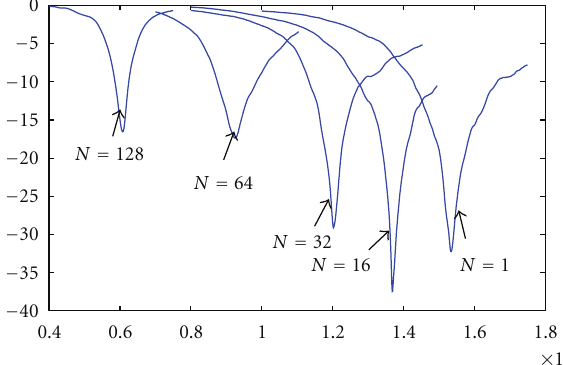
Figure 4: Measured input return loss of these